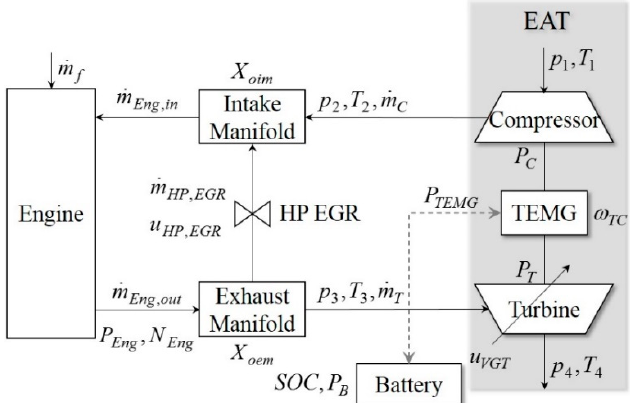
Figure 1. Schematic of the electrically assisted turbocharger (EAT)-assisted diesel engine. The nomenclature for all the symbols can be found in Nomenclature